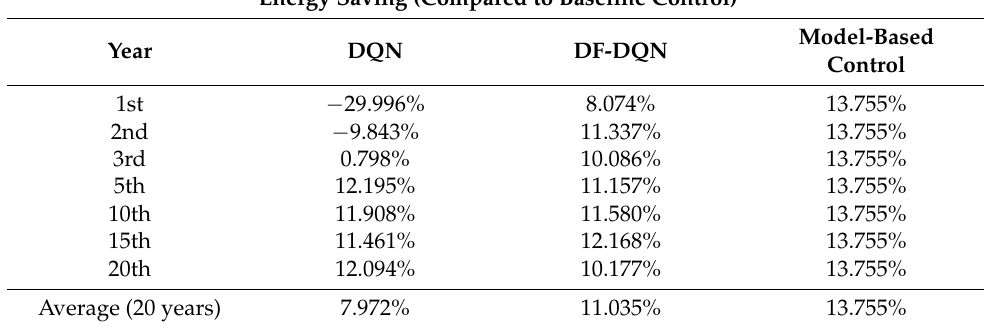
Table 3. Partial comparison effect